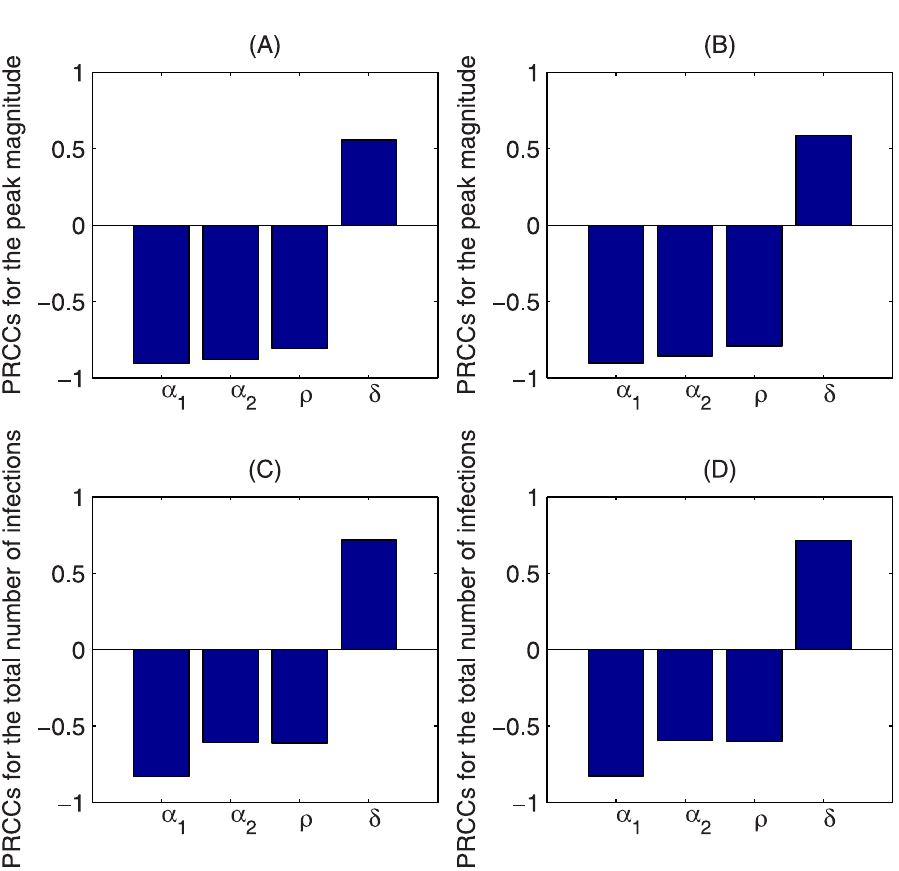
Fig 7. Sensitivity analysis. LHS-PRCC results for peak magnitude of infected individuals and total number of infections of system (1) with respective to α 1 , α 2 , ρ , δ . The other parameters are fixed as estimated in Table 1. The sensitivity analysis is done with 2000 bins, the left and right column correspond to system (1) with media functions f 1 and f 2 ,